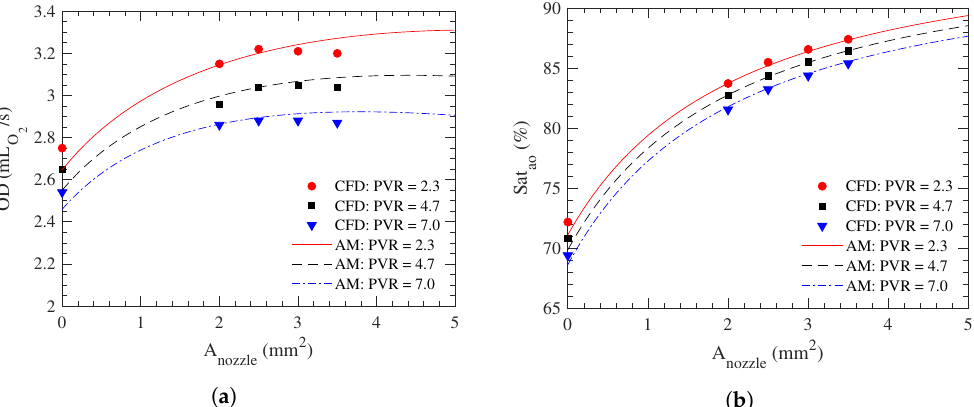
Figure 9. ( a ) The oxygen delivery, OD ; and ( b ) the aortic oxygen saturation, Sat ao , as a function of the nozzle area, A nozzle , at different PVR values. Lines correspond to the algebraic model (AM) and symbols to the